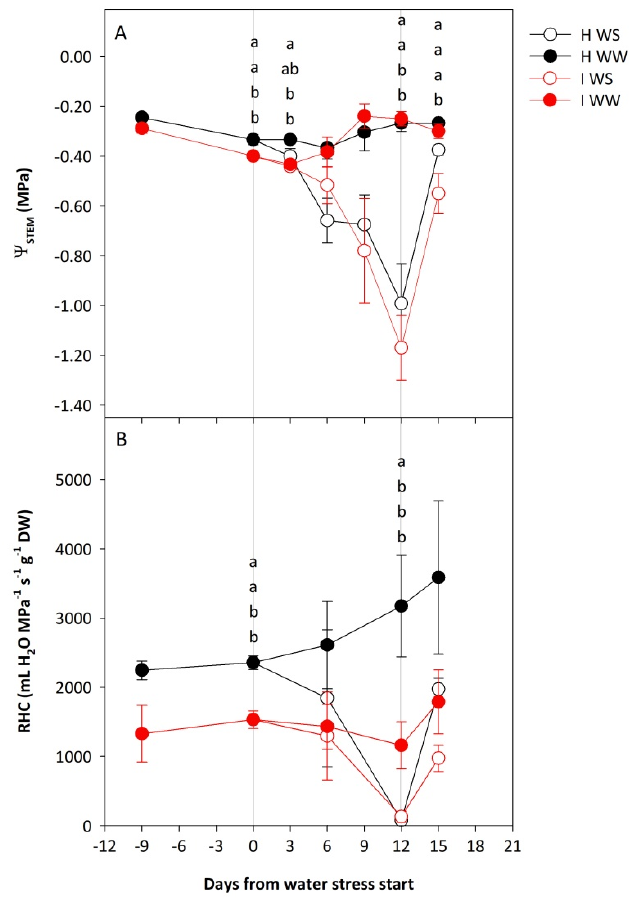
Figure 1. Stem water potential ( Ψ STEM ; A ) and root hydraulic conductivity (RHC; B ) of potted own-rooted grapevines of cv. Schioppettino before the water stress, during the water stress, and after the recovery. Plants are separated regarding to plant health and water status: well-watered healthy (H WW), well-watered GFLV-infected (I WW), water-stressed healthy (H WS) and water-stressed GFLV-infected (I WS) plants. Error bars represent standard errors. For each time point separately, data were processed through ANOVA (significance reported in Supplementary Table S1), and means were separated with a Student Newman Keuls test ( p < 0.05; different letters represent significant differences between means). Grey lines represent the beginning and the end of water stress period.